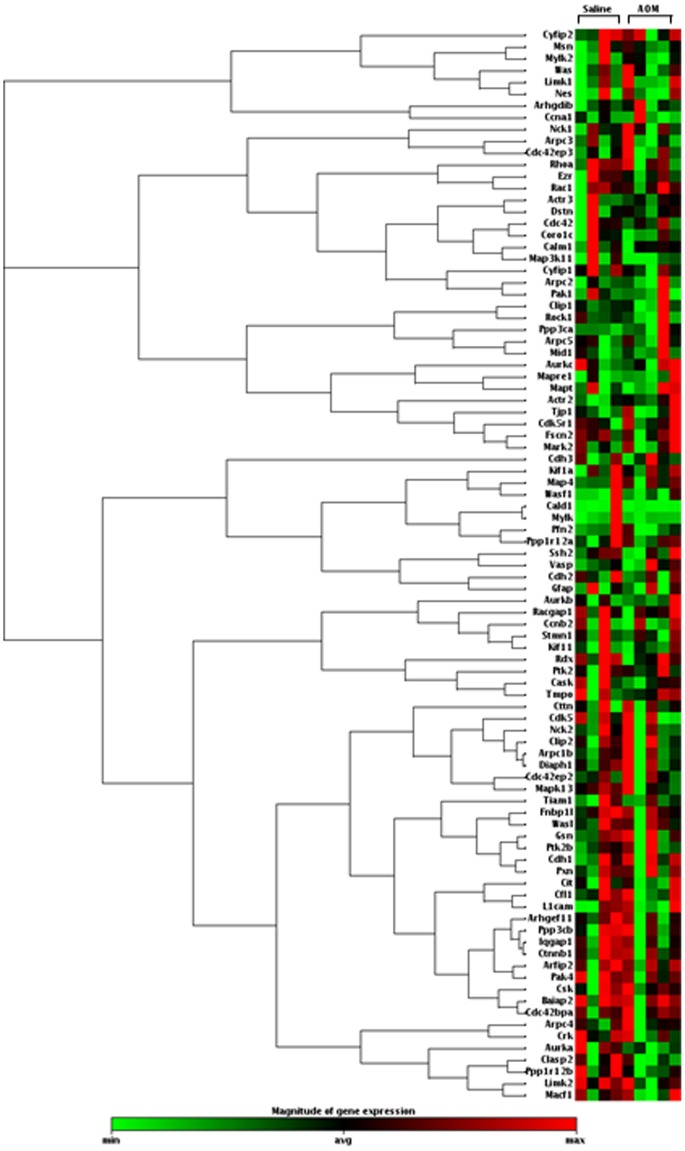
Clustergram for 9 rats (four saline and five AOM) showing the fold up- or down-regulation of genes involved in cytoskeleton regulation.The alterations in cytoskeletal gene regulation of precancerous (AOM-treated) rat cells compared to control (saline-treated) rat cells suggest possible involvement of the cytoskeleton in determining the structural differences measured by LEBS (Fig. 2).